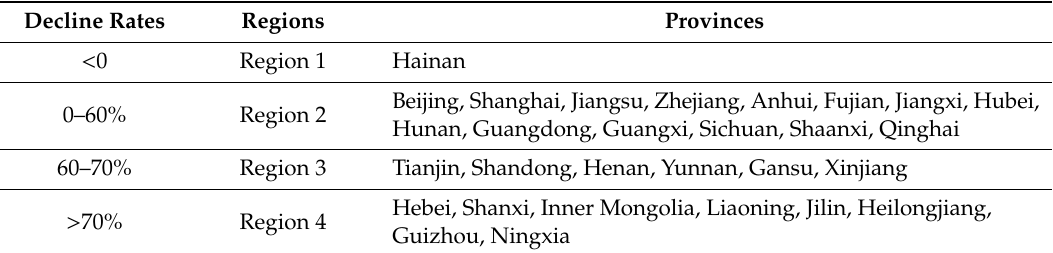
Table 14. Provincial classification by carbon